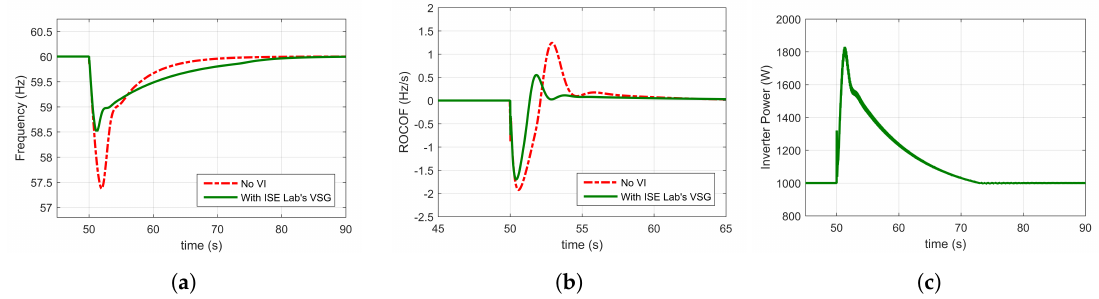
Figure 13. Simulation results from ISE lab’s topology: ( a ) system frequency after a step-increase of 2 kW load; ( b ) ROCOF after a step-increase of 2 kW load; ( c ) increase in inverter power as a response to system frequency decrease